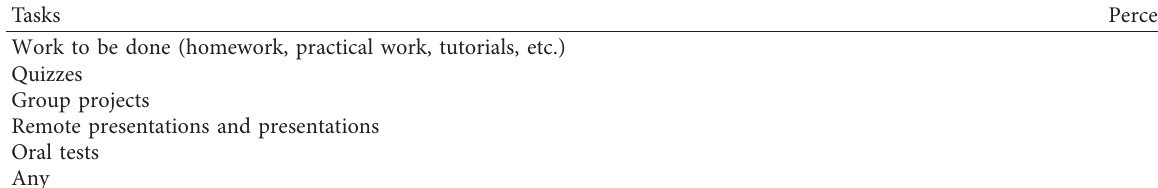
Table 7: Types of assessments